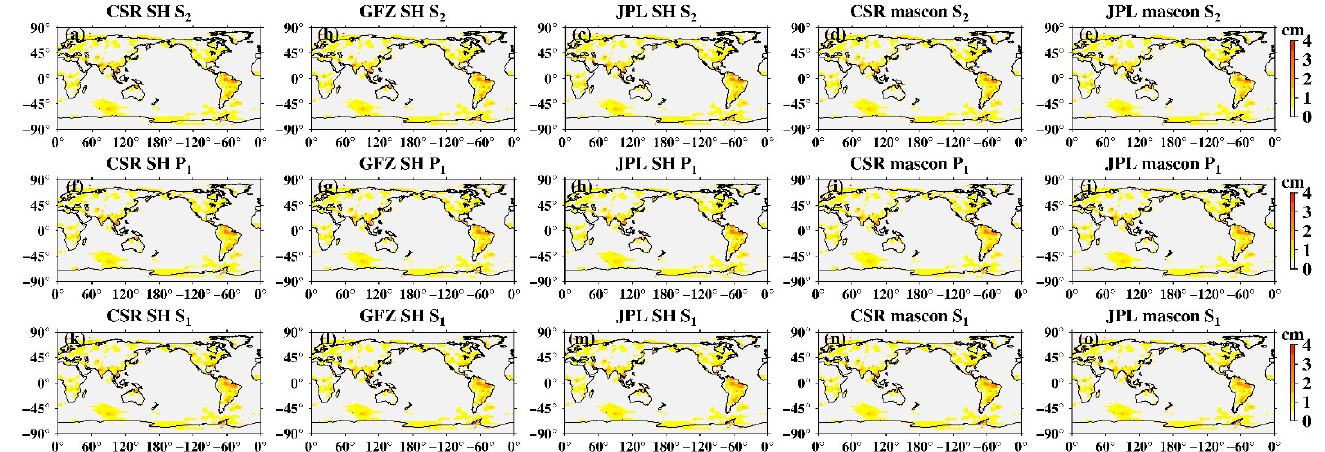
Figure 2. Least-square fit of the global amplitudes of S 2 , P 1 , and S 1 tide aliasing. ( a – e ) Amplitude maps of the S 2 aliasing in CSR SH data, GFZ SH data, JPL SH data, CSR mascon data, and JPL mascon data, respectively; ( f – j ) amplitude maps of the S 2 aliasing in CSR SH data, GFZ SH data, JPL SH data, CSR mascon data, and JPL mascon data, respectively ; ( h – o ) amplitude maps of the S 1 aliasing in CSR SH data, GFZ SH data, JPL SH data, CSR mascon data, and JPL mascon data, respectively.